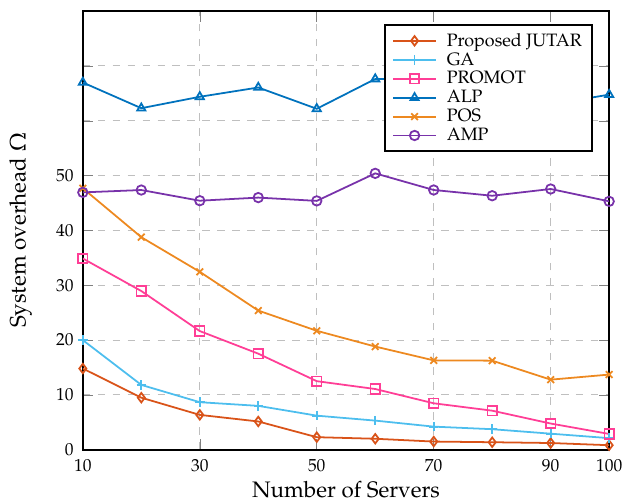
Figure 5. Comparison results of the system overhead vs. number of servers for the proposed JUTAR